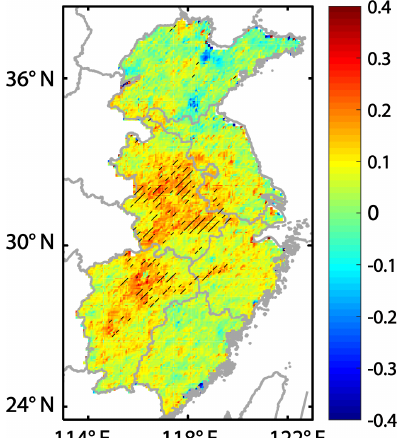
Figure 9. The spatial distribution of the ADRF trend in eastern China during 2000–2016 (unit: Wm − 2 month − 1 ). Hatched regions represent those exceeding the 90% significance